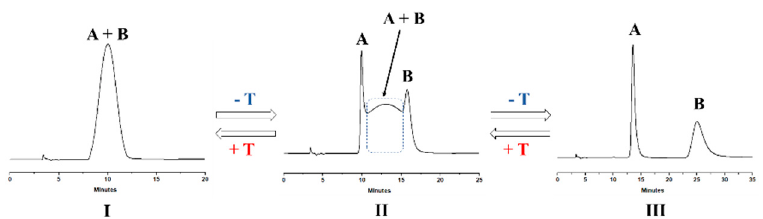
Figure 2. Typical profiles of dynamic chromatograms related to chromatographic resolution of species A and B which undergoes interconversion (cases I and II) or not (case III) during their HPLC discrimination (dependence of plateau zone on different rates of interconversion).